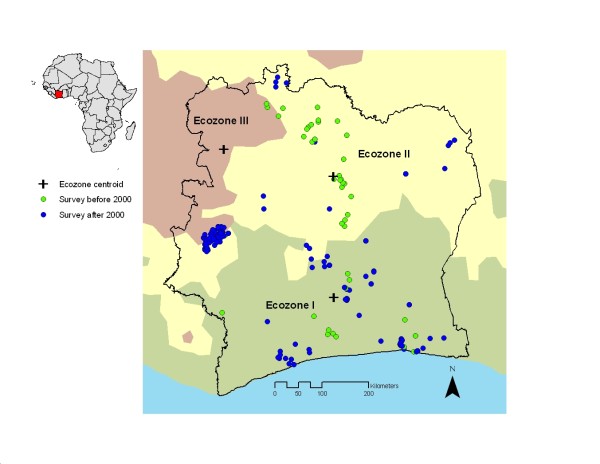
 Geographical distribution of Plasmodium spp. surveys locations based on compiled data on children aged <16 years between 1988 and 2007 in Côte d’Ivoire. The data were stratified in two categories: survey carried out before and since the year 2000. The extent of three major ecozones in the country, which was derived from various satellite data, is displayed in the background. Centroids of the ecozones are given as black symbols.